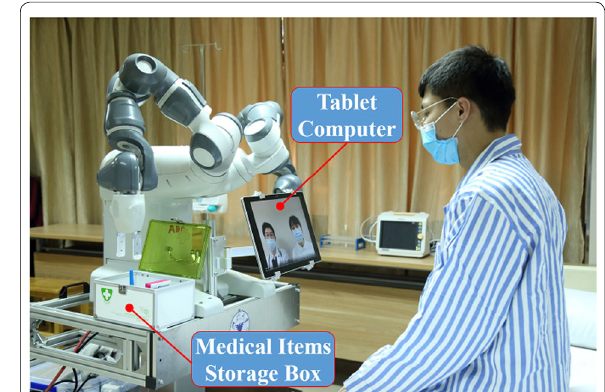
Figure 6 Remote daily consultation of physical and mental conditions using the telepresence system